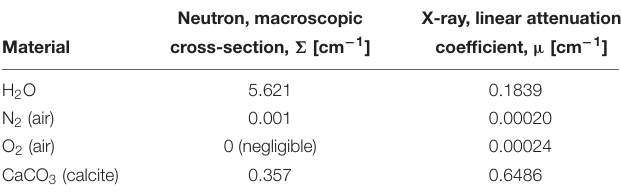
TABLE 1 | Comparison of the cross-sections for neutrons and X-rays. Neutron, macroscopic X-ray, linear